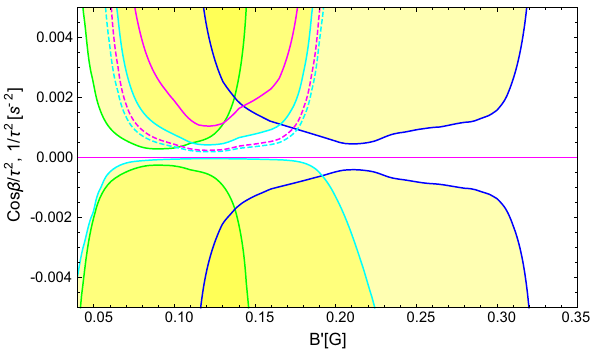
Fig. 6 Exclusion regions for 1 /τ 2 and cos β/τ 2 extracted from our measurements of E B and A B . Curves of different colors, corresponding tothecolors ofbins inFig.5confine regions excludedbymeasurements at different values of B c , respectively for positive and negative cos β in upper and lower parts of this Figure